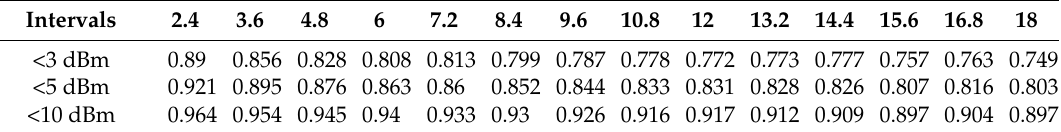
Table 4. The statistics probabilities of absolute RSS differences ranges between manual radio map and the Kriging interpolated ones.